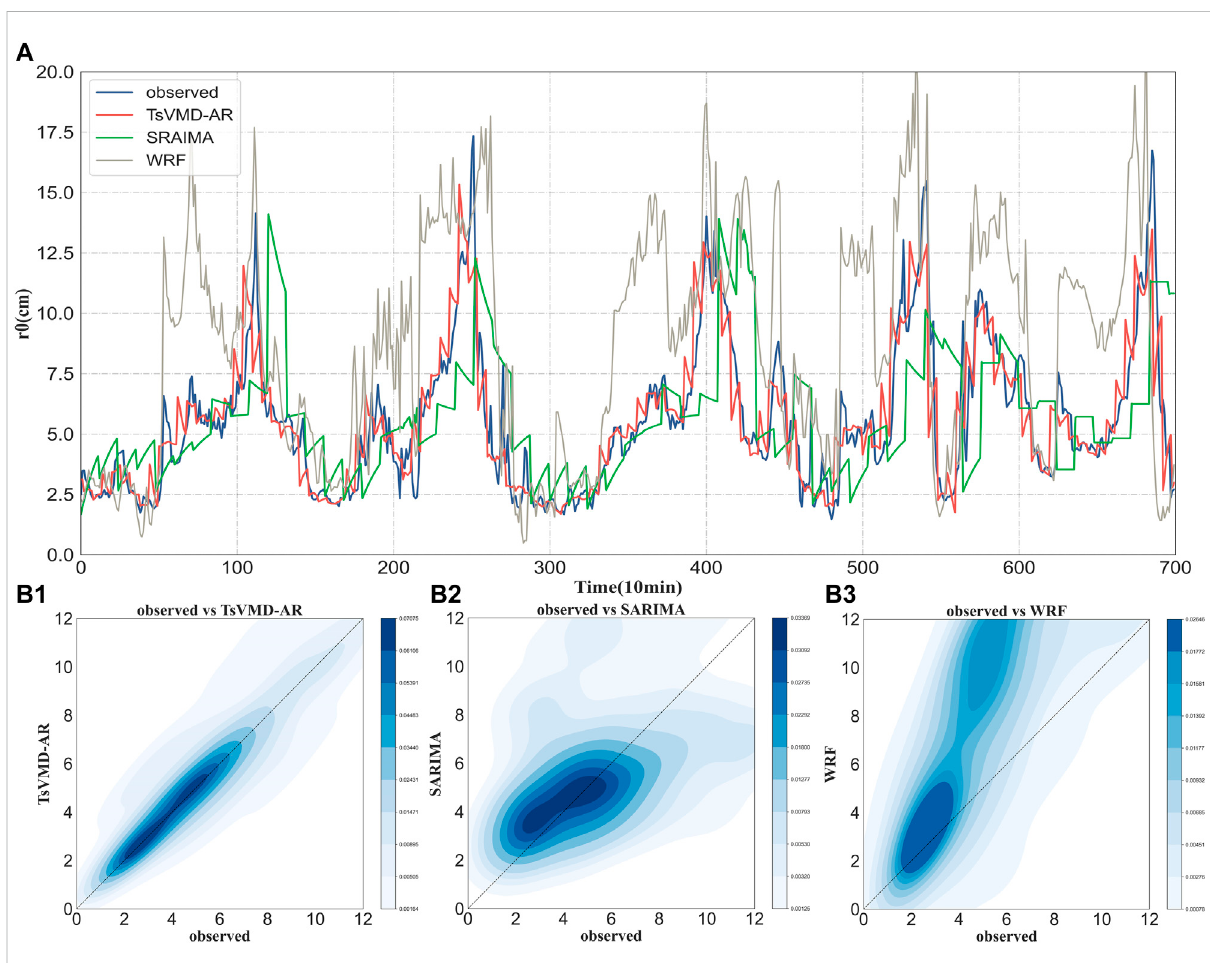
FIGURE 7 Forecasting results of theproposed method and the contrast method for period 3: (A) observed atmosphericturbulence (blue) and forecasting results of TsVMD-AR(red), SARIMA (green), and WRF (grey); 2D histogramsof observed atmospheric turbulence verse forecasting results ofTsVMD- AR (B1) , SARIMA (B2) , and WRF (B3)